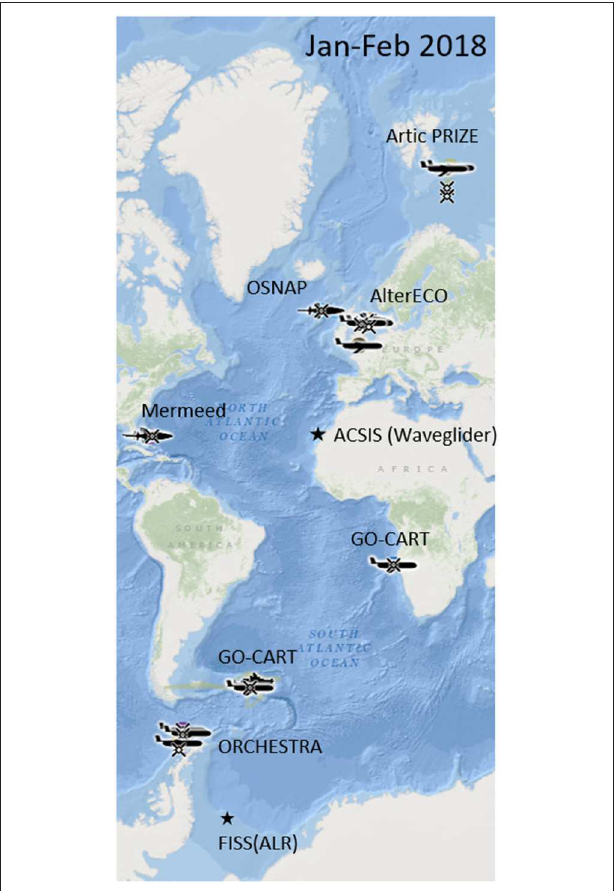
FIGURE 2 | Distribution of MARS operations Jan/Feb 2018. All deployments used Slocum/Seagliders unless otherwise